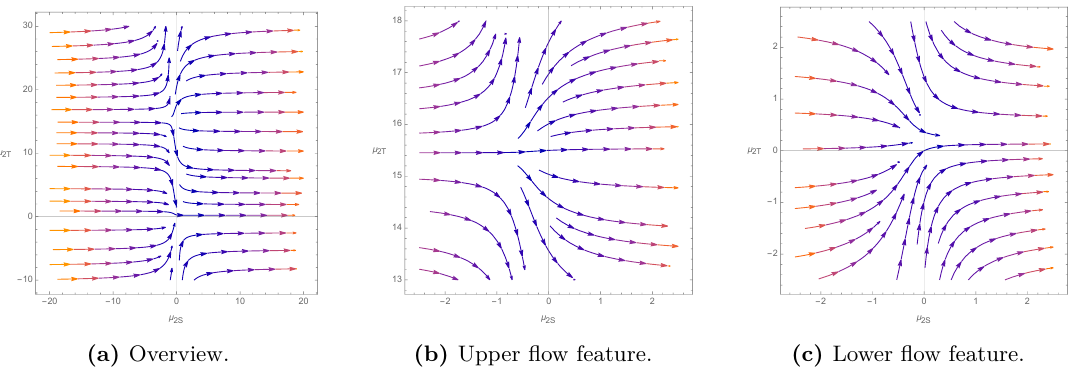
Figure 2. Double trace flows without fixed flows for M = 82 . Compare the coarse grained view